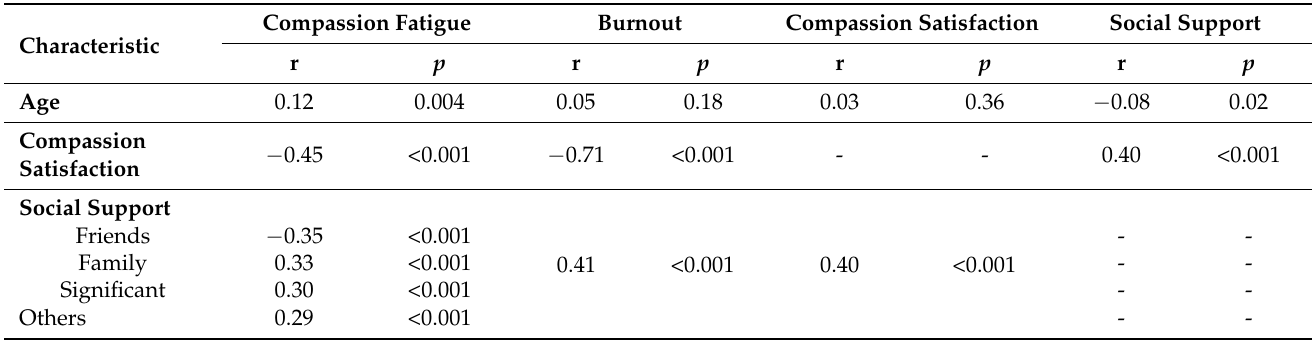
Table 1. Results of Simple Regression